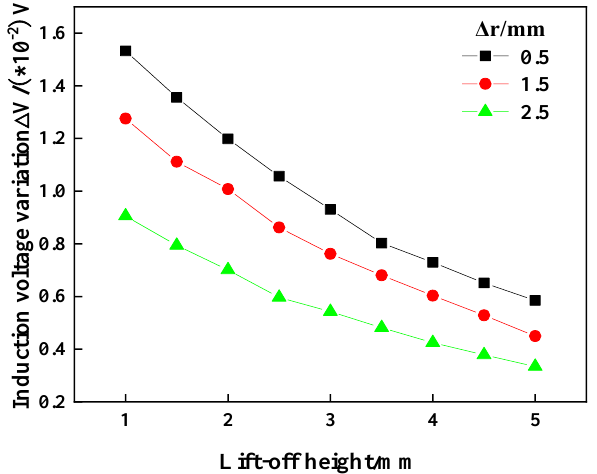
Figure 10. The influence of inner and outer diameter difference of the detecting coil on measuring signal.